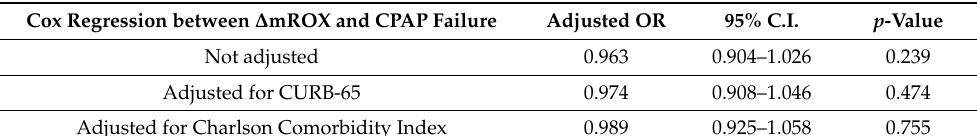
Table 2. Association between changes in mROX before and during CPAP, and risk of CPAP failure. CPAP = continuous positive airway pressure; mROX = PaO 2 /FiO 2 /respiratory rate.